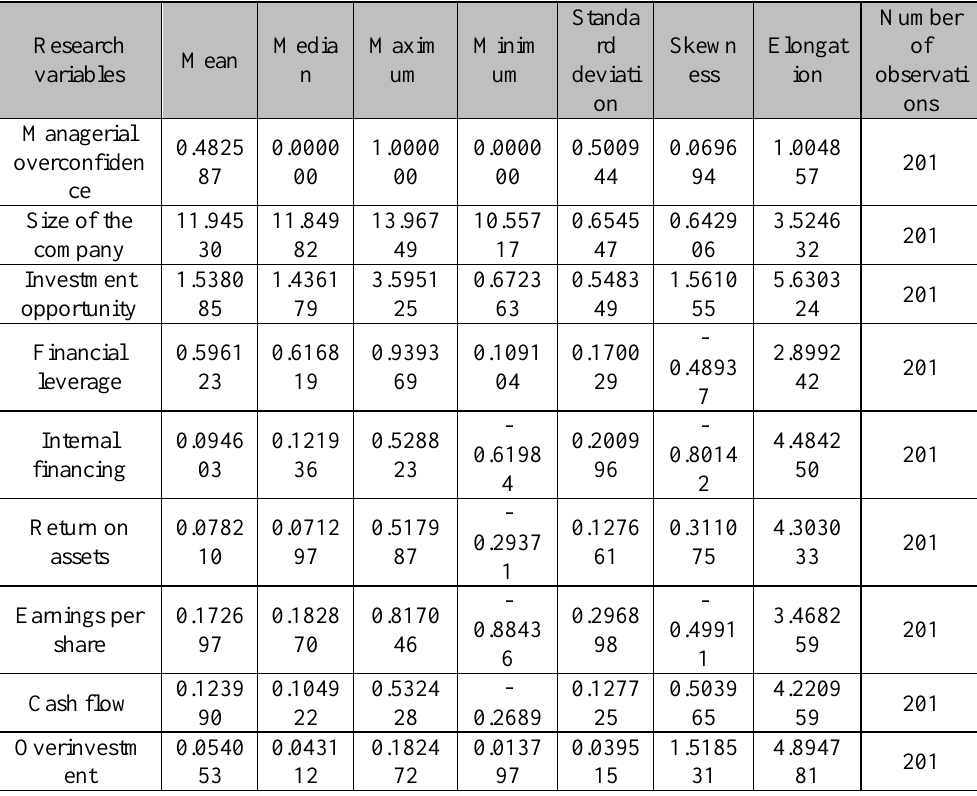
Table 3. Descriptive statistics - overinvestment